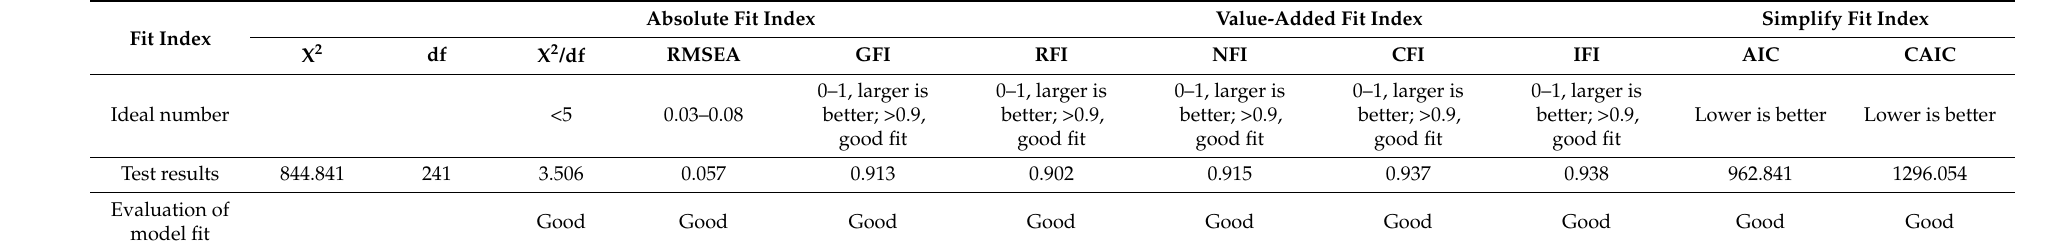
Table 4. Fit indices of the